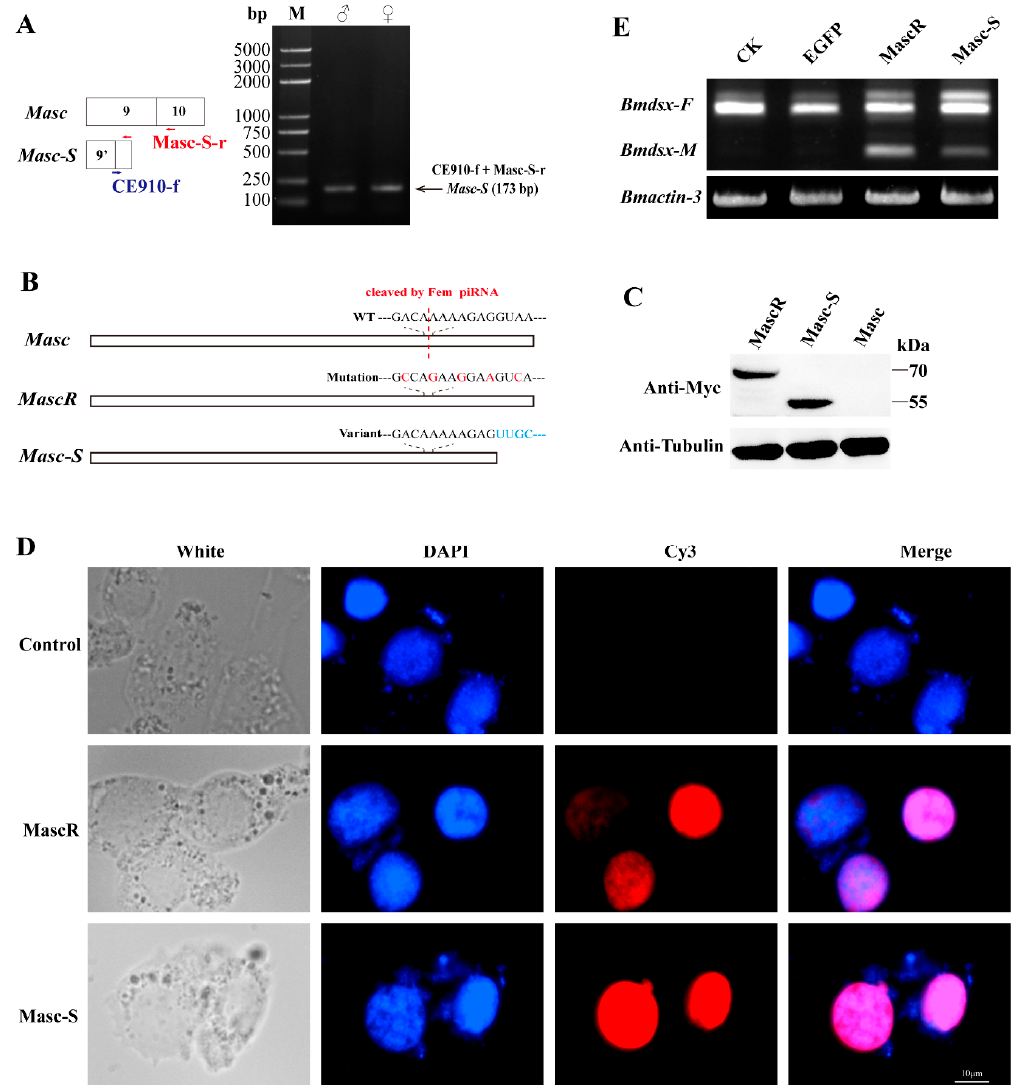
Figure 2. Expression of Masc-S in the silkworm and cell line. ( A ) RT-PCR for Masc-S in both sexes. The reverse primer Masc-S-r lies in exon 10 of Masc as well as Masc-S. The forward primer CE910-f, specific to Masc-S , overlaps the junction of exons 9’ and 10. PCR production by using the CE910-f and Masc-S-r primers was cloned and sequenced in order to confirm the sequence. ( B , C ) Over-expression of full-length Masc , splice variant Masc-S and piRNA-resistant MascR in the female-specific cell line BmN. MascR contains five nucleotide substitutions (red characters) from the wild-type (WT) sequence, which makes it resistant to cleavage by Fem piRNA [8] . The Myc-tagged Masc , MascR and Masc-S coding sequences were cloned into the pSL1180 vector, respectively. The recombinant expression vectors pSL1180-Myc-Masc, pSL1180-Myc-MascR and pSL1180-Myc-Masc-S, were transfected into the silkworm female-specific cell line BmN. Western blot was performed to detect Masc, MascR and Masc-S proteins with anti-Myc-tag antibody, with α -tubulin used for the internal control. ( D ) Subcellular location of MascR and Masc-S in the silkworm cell lines. DAPI-treated nuclei, red fluorescence for Cy3-treated MascR and Masc-S proteins, and the merged images are shown. ( E ) E ff ect of Masc-S over-expression on sex-specific alternative splicing of Bmdsx . Line CK represents the control, lines EGFP , MascR and Masc-S mean that psl1180-Myc-EGFP, psl1180-Myc-MascR and psl1180-Myc-Masc-S vectors were transfected into BmN, respectively. Bmactin-3 was used for internal control. The band of male-specific splice type ( Bmdsx-M ) of Bmdsx was induced when Masc-S was over-expressed in BmN. However, expression level of Bmdsx-M induced by Masc-S is less than that by MascR